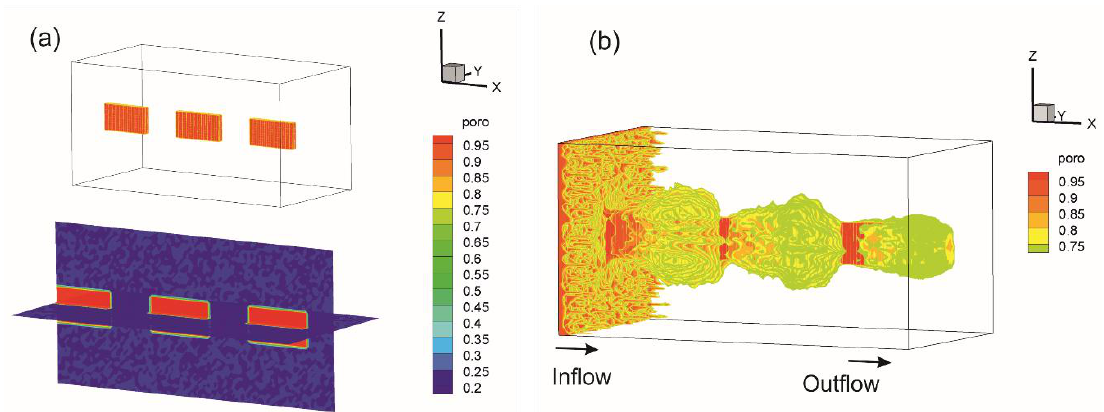
Figure 5. Porosity profile of fractured rock with fluctuations in the interval [−0.05, 0.05]. ( a ) Initial condition; ( b ) dominant wormhole.